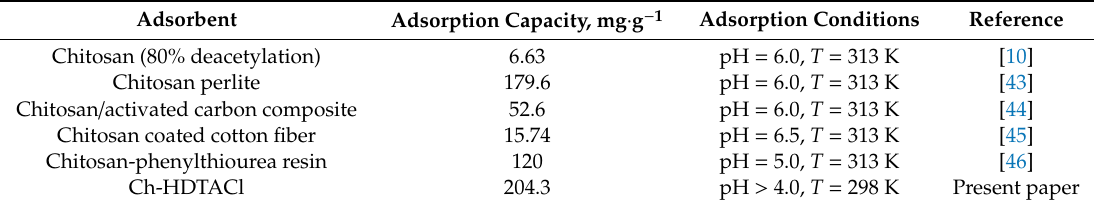
Table 3. Adsorption capacities of some adsorbents cited in the